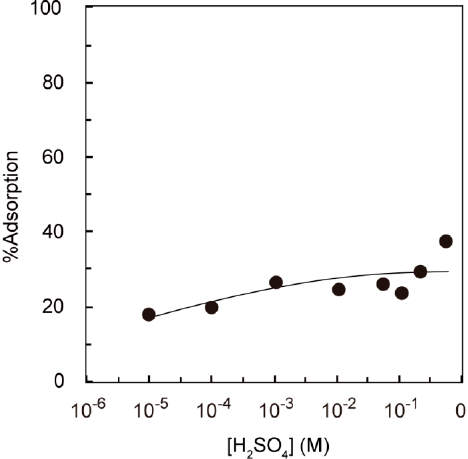
Figure 5. Effect of H 2 SO 4 concentration on the removal of Ag(I) on the PEI ‐ microalgae. Conditions: Ag(I) concentration = 0.2 mM, CS(NH 2 ) 2 concentration = 0.05 M, weight of adsorbent = 10 mg, volume of test solution = 10 mL, temperature = 30 °C, and shaking time = 24 h.